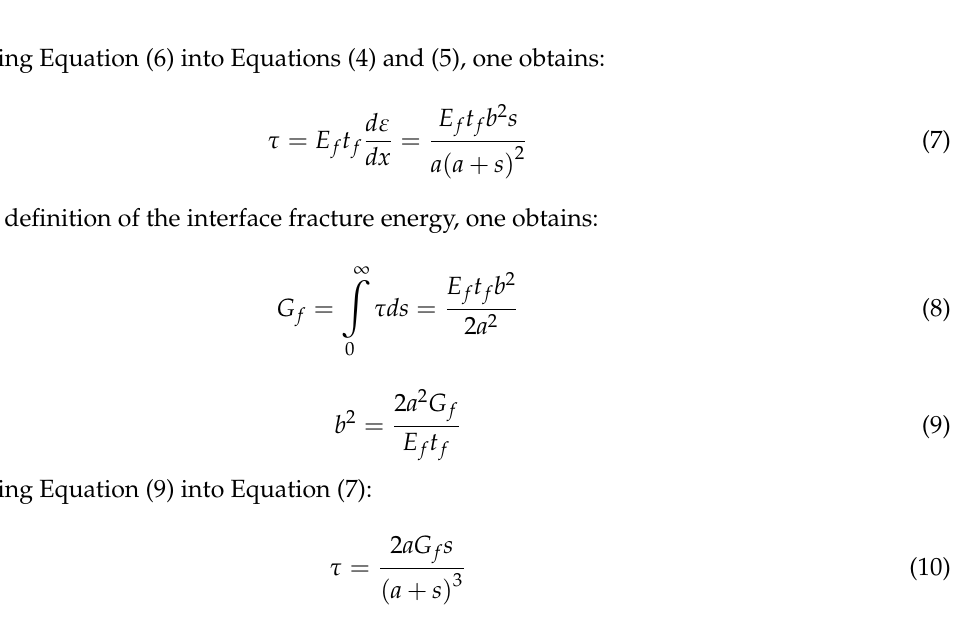
11 of 19 Figure 5. Experimental value vs. fitting curve of the strain-slip relationship: ( a ) Testing group of the sandblasted specimen; ( b ) Testing group of the specimen with different CFRP layers; ( c ) Testing